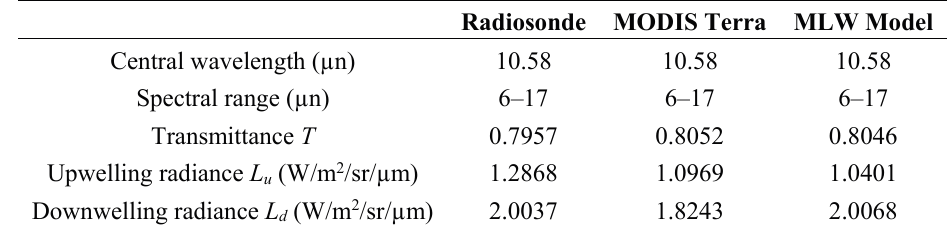
Table 1. Broadband atmospheric parameters computed by Modtran 5 simulations, using the atmospheric profiles of the radiosonde data, of the MODIS Terra image and of the mid-latitude winter (MLW) predefined